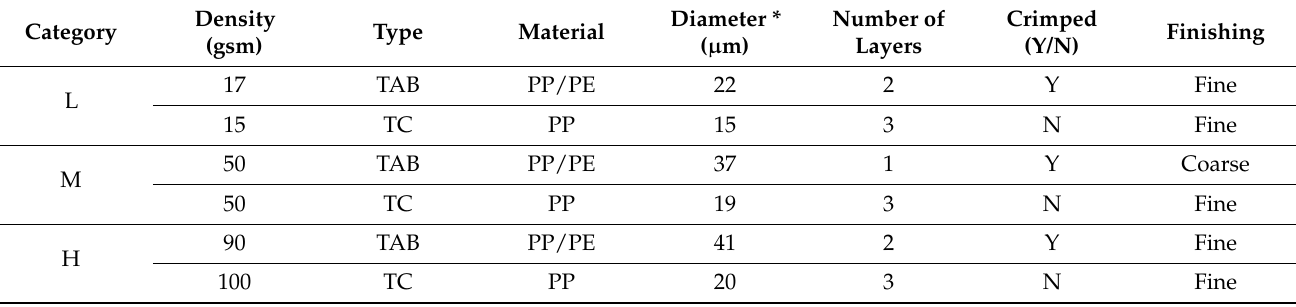
Table 1. Manufacturing parameters of nonwoven fabrics